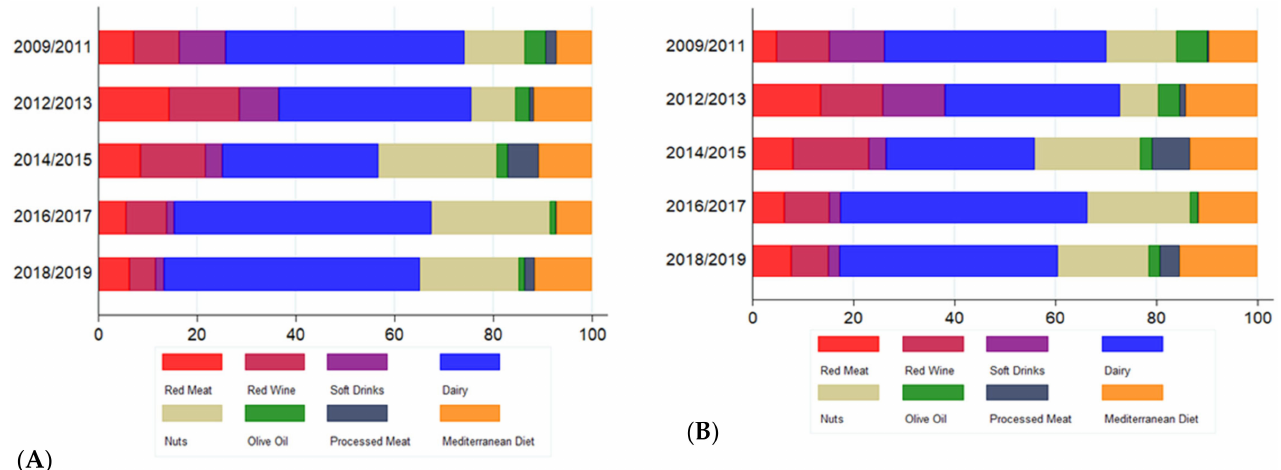
Figure 6. Proportion of tweets ( A ) and retweets ( B ) generated by each food group between 2009 and 2019. Initially aggregated into a three-year period, and afterwards into periods of two years. X-axis: Percentages (%) were calculated with respect to the total number of tweets and retweets,